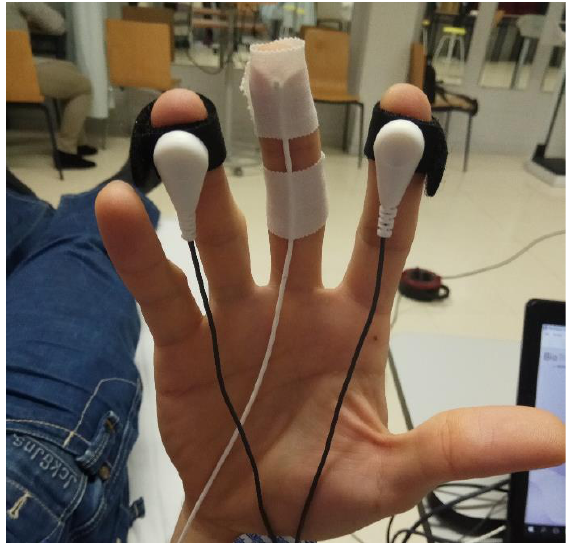
Figure 2. Placement of electrodes for SC and Temp on the right hand. Measurements for the physiological variables were collected at different moments (Figure 3): Baseline (average of the 5 min before the intervention); Dry needling (average of the 10 s of the needling technique); Post-1 (average of 1 min immediately after ending the intervention); Post-2 (average of 1 min, 9 min after ending the intervention).